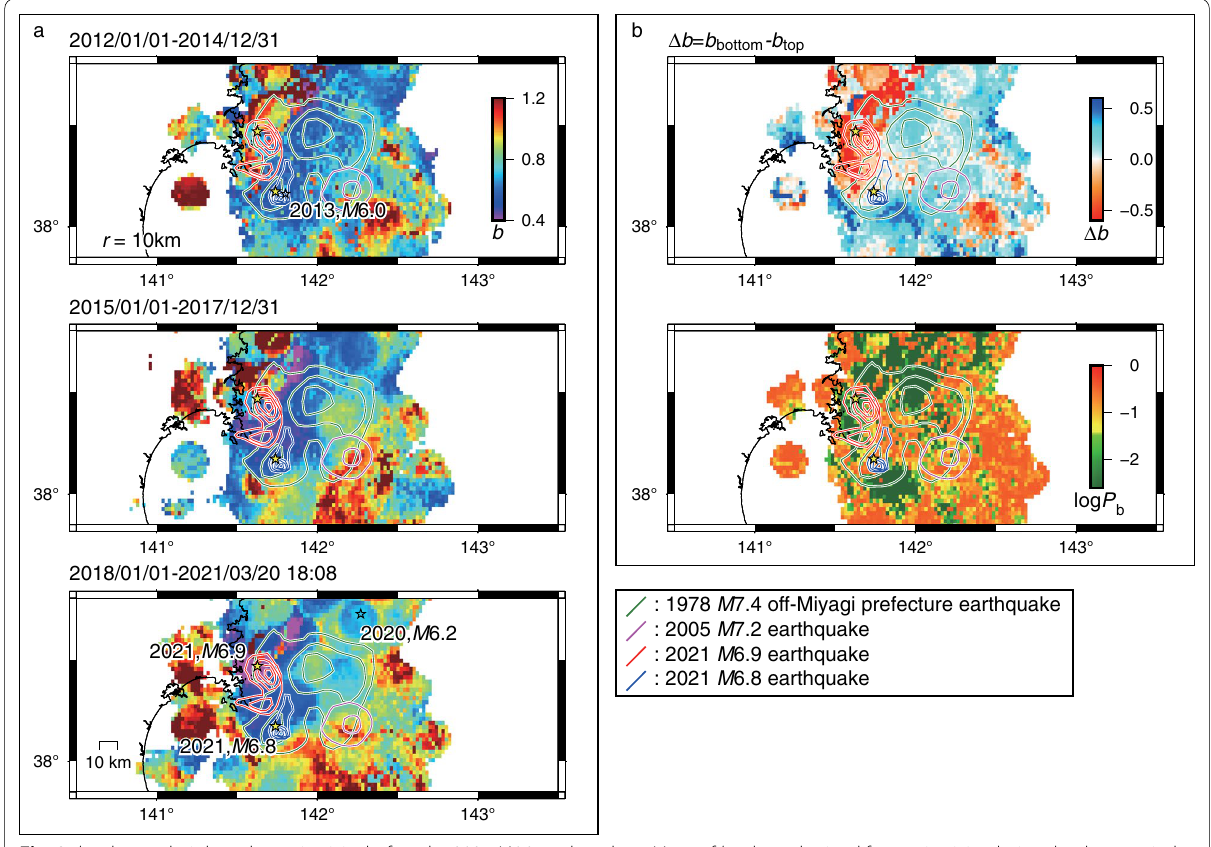
Fig. 2 b -value analysis based on seismicity before the 2021 M 6.9 earthquake. a Maps of b values obtained from seismicity during the three periods; top panel: from 2012 to 2014, middle panel: from 2015 to 2017, and bottom panel: from 2018 to immediately before the 2021 M 6.9 earthquake. In making these maps, we selected earthquakes along the plate interface (Nakajima and Hasegawa 2006): earthquakes were chosen if their depths were within a range from 5 km above the interface to 15 km below it. We calculated the b value and simultaneously M c (Figures S1a-c of Additional file 1) for each grid node (0.02° spacing) selecting all events within a search radius of 10 km. Other symbols are the same as in Fig. 1. Epicenters of M 6.0 earthquakes that occurred in the corresponding periods are shown by open stars. b Top panel: Δ b ( ≥ values between the periods 2012–2014 ( b top : top panel in a ) and 2018–2021 ( b bottom : bottom panel in a ). Bottom panel: log P b , the logarithm of the probability that b bottom is not different from b